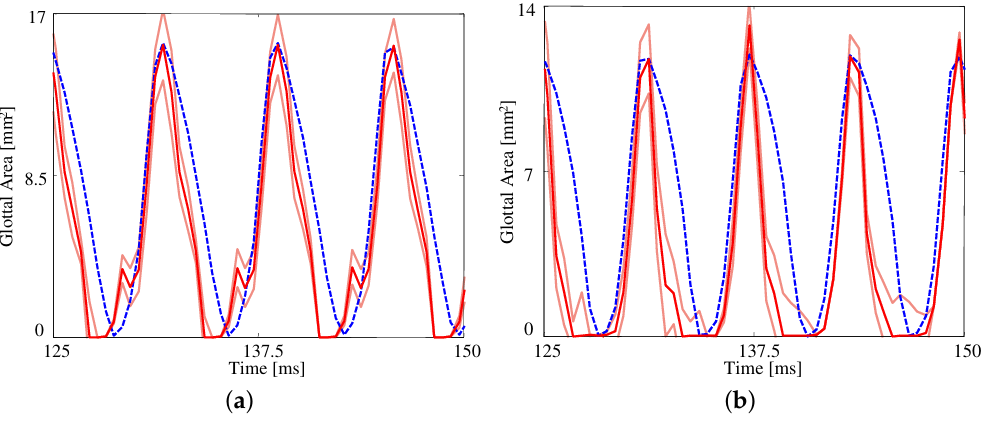
Figure 5. The glottal area waveform extracted from HSV of self-oscillating silicone vocal folds at p sub = 1.00kPa ( a ) without medial compression and ( b ) with medial compression. Blue dashed line: HSV; red solid line: FE model; orange solid lines: uncertainty bounds from the FE